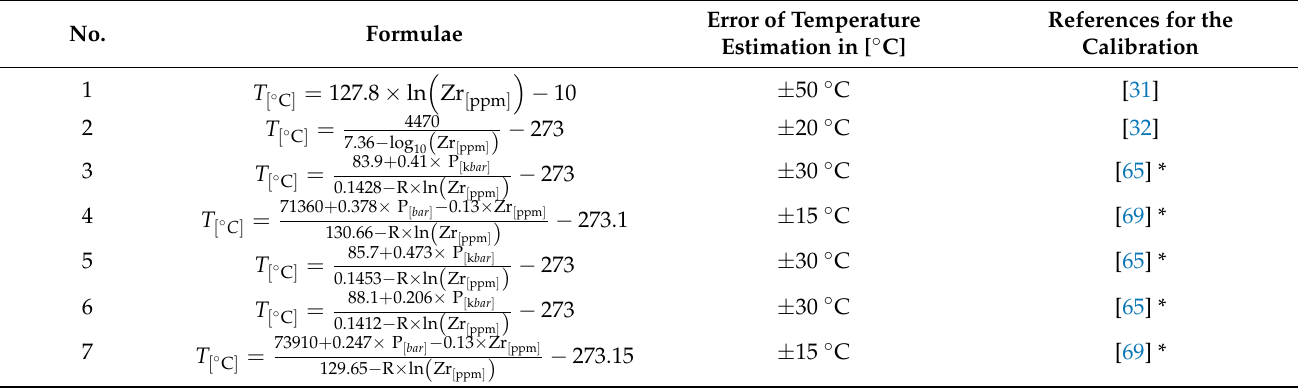
Table 2. Compilation of the existing Zr-in-rutile (ZIR) geothermometers calibrated by various authors. The gas constant is R = 8.3145 J × mol − 1 × K − 1